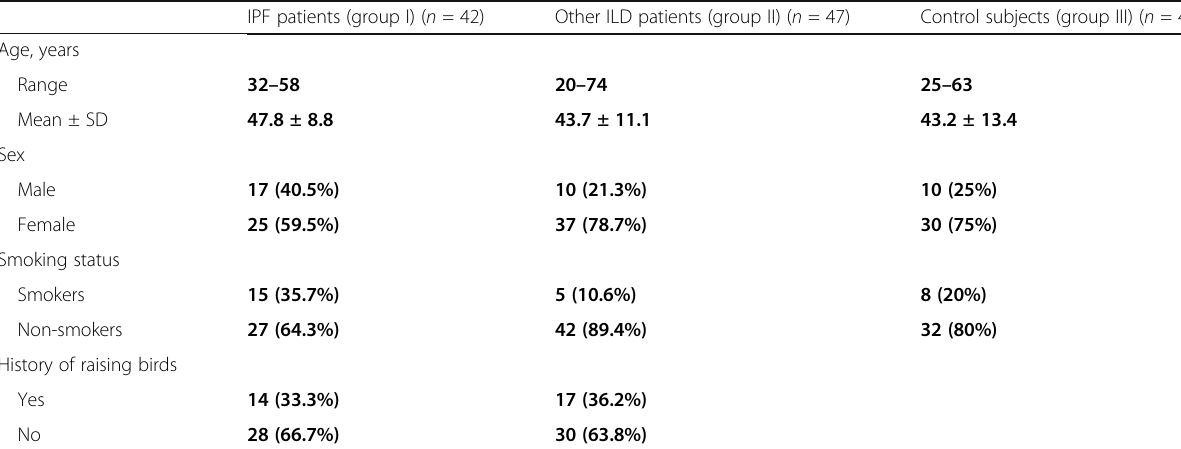
Table 1 Demographic characteristics of the three groups